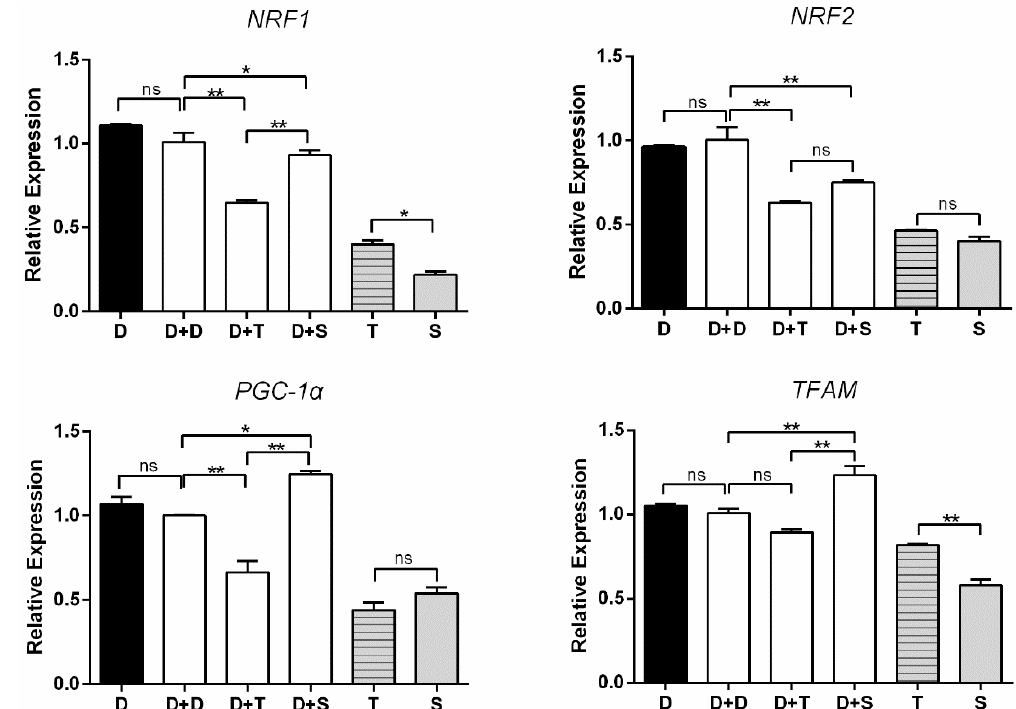
Figure 5. Expression levels of four mitochondrial biogenesis-related genes in primary cells and cybrids. Black column: DF-1 cells and primary cells; white columns denote cybrids. n = 3 per group. * means p < 0.05, ** means p < 0.01, and ns means p > 0.05.